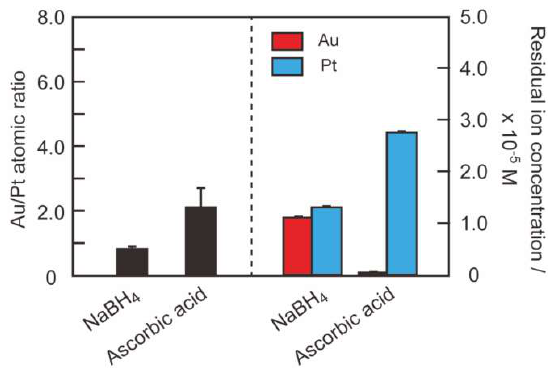
Figure 7. Au/Pt atomic ratios of the metallic precipitates determined by EDS-SEM (left axis) and residual metal ion concentrations in the supernatants determined by ICP-OES (right axis) with the common reducing agents NaBH 4 and ascorbic acid. Samples were separated by centrifuging reaction mixtures of peptides and metal ions (HAuCl 4 + H 2 PtCl 6 ). (Reducing agent) = 1.0 × 10 −3 M and (HAuCl 4 ) = (H 2 PtCl 6 ) = 5.0 × 10 − 5 M in water. The reactions were conducted at 40 ◦ C for 24 h in the dark (mean ± SD, n =